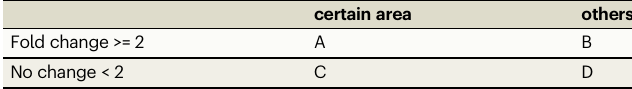
Table 1 | 2 × 2 table used in Fisher ’ s exact test